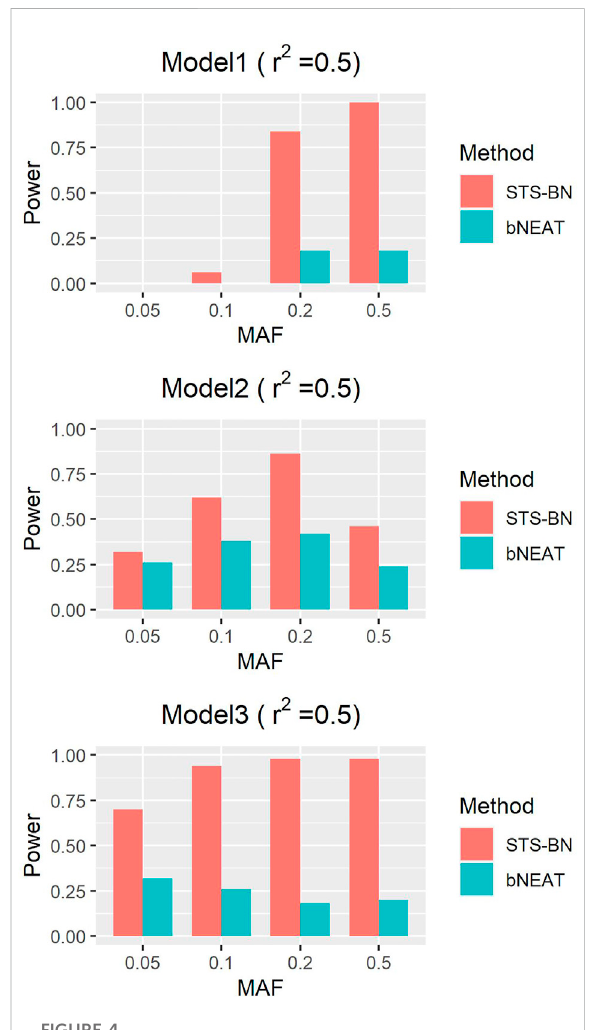
FIGURE 4 Performance comparison of STS-BN and bNEAT. The input orders of markers are randomly disturbed and r 2 = 0.5.